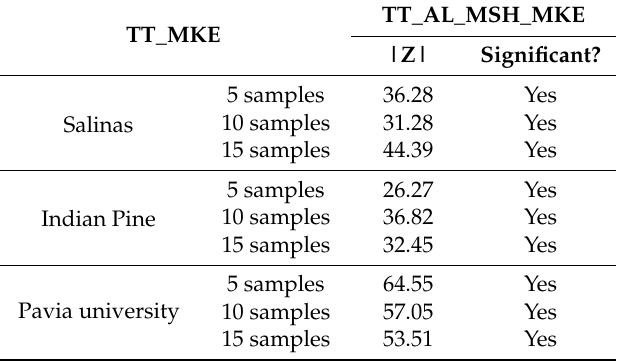
Table 4. The value of Z-test in the different dataset. AL, active learning.